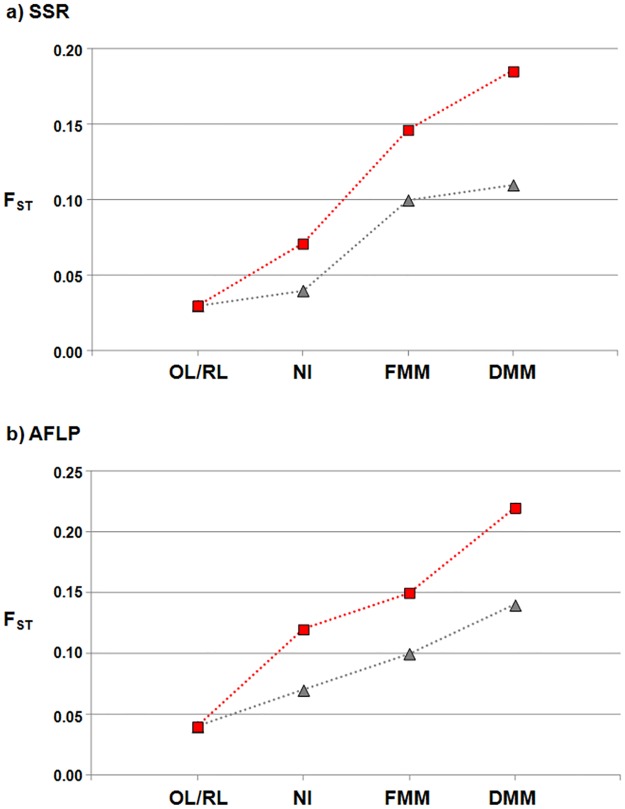
Divergence between populations.Pairwise FST values between the OL and the RL, NI, FMM and DMM (red squares) populations, and between the RL and the OL, NI, FMM and DMM (grey triangles) populations for the SSR (a) and AFLP (b) molecular markers.